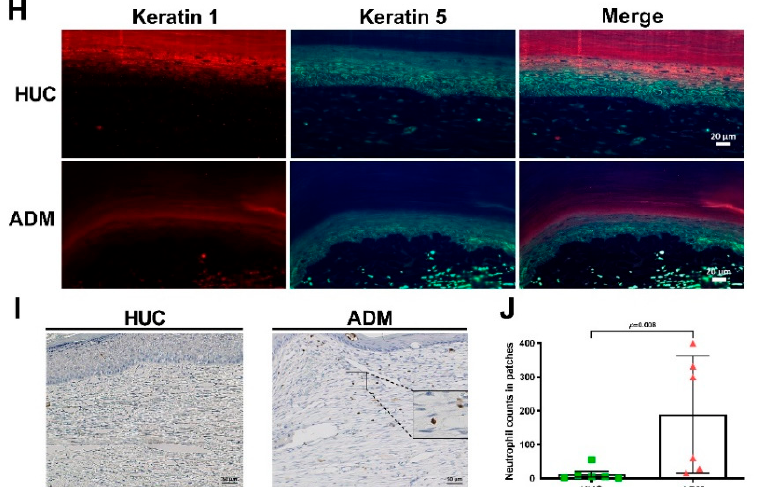
Figure 3. The ADM patch accumulates neutrophils and or monocytes with delayed and disorganized skin epithelialization. ( A ) PSC lambs with SB defects results in complete wound healing. ( B ) Use of the HUC patch during SB repair leads to complete, partial or unrepaired defect sites. ( C ) ADM patch use to repair SB defects in utero causes lambs to be born with variable wound healing capabilities, with those being complete, partial or remaining completely unrepaired at defect sites. ( D ) Representative image of a PSC group mid-level sagittal section of the defect repair site using Masson’s trichrome staining (1000 µ M). ( E ) A representative mid-level sagittal section image of a HUC patch repaired defect site by Masson’s trichrome staining (500 µ M). A 50 µ M magnified image of the skin at the lesion is shown in the lower panel. ( F ) A representative mid-level sagittal section image of a ADM patch repaired defect site by Masson’s trichrome staining (500 µ M). A 50 µ M magnified image of the skin at the lesion is shown in the lower panel. ( G ) Skin epithelialization occurred in all lambs repaired with the HUC patch. ( H ) Immunofluorescent anti-keratin 1 and anti-keratin 5 co-staining of defects repaired using the HUC patch and ADM the patch. ( I ) MPO staining of HUC and ADM patches at defect repair sites. ( J ) Quantification of the number of neutrophils and or monocytes infiltration, that being MPO positive cells, into HUC and ADM patches at defect repair